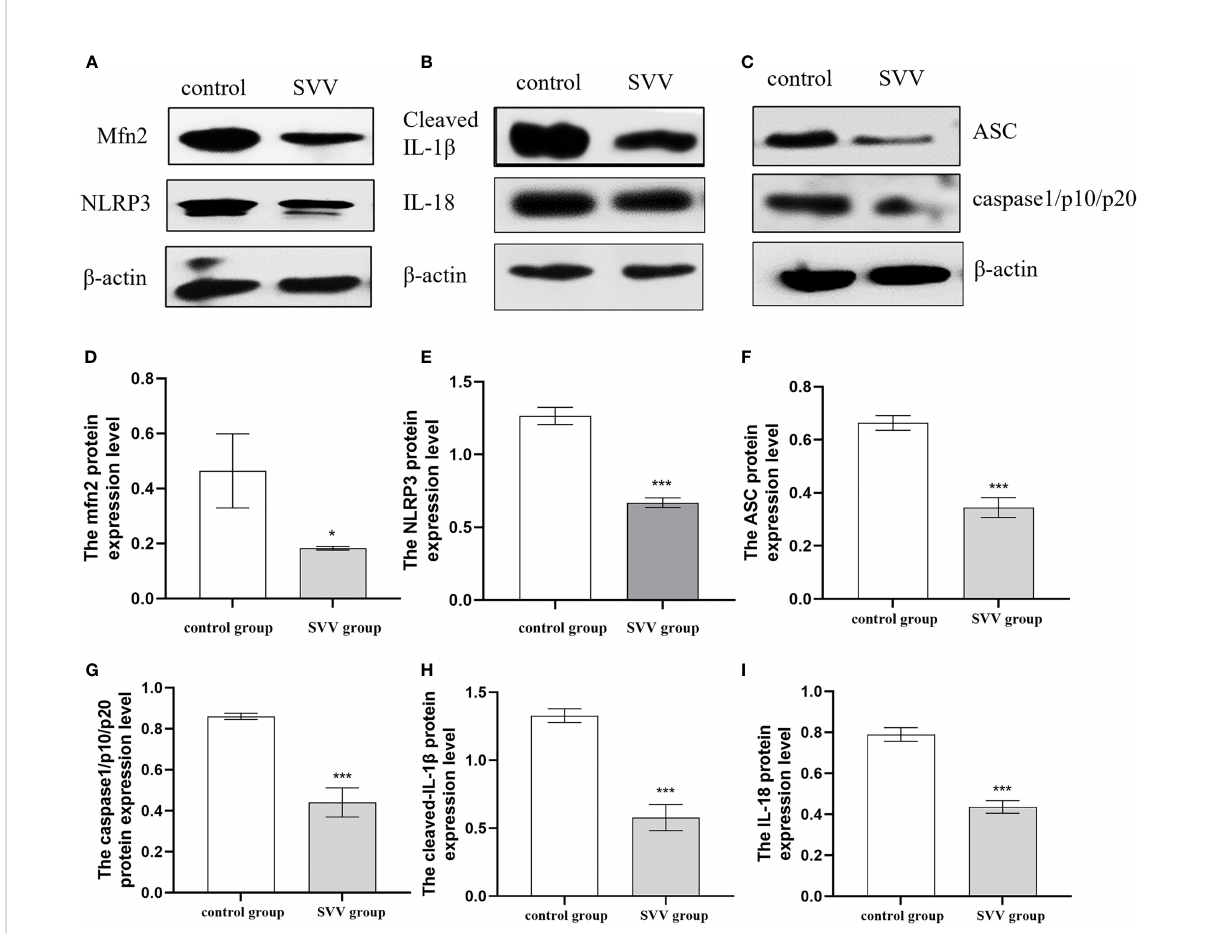
FIGURE 1 SVVdecreasedMfn2 expression, inhibitedNLRP3in fl ammasome activation. (A – C) Thewesternblotassay forMfn2, NLRP3, ASC,caspase1/p10/p20, cleaved-IL-1 b andIL-18. (D – I) The relativeproteinexpression levelofMfn2, NLRP3,ASC, caspase1/p10/p20,cleaved-IL-1 b andIL-18. UnpairedT-test were usedtoinvestigatethesigni fi canceofdifferencesbetweenthe experimental groups andthecontrol group*;P< 0.05, ***;P<